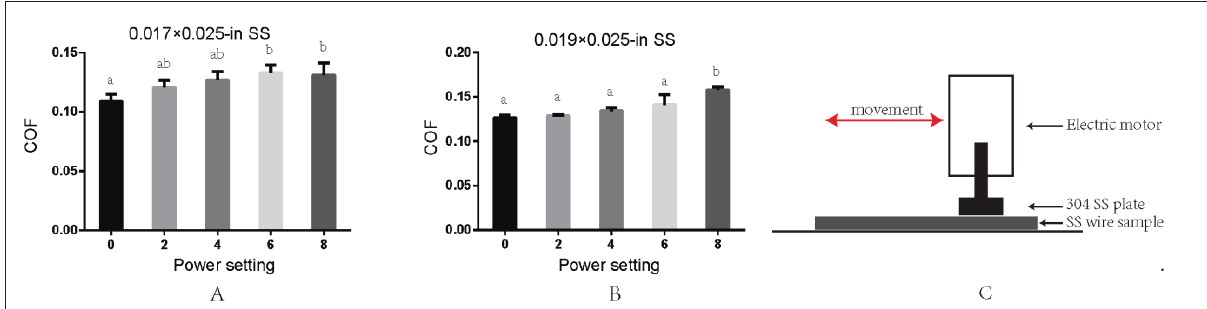
Figure 2. The COF of unheated and heated SS wire specimens. (A) Unheated 0.017 × 0.025 inch SS wire specimens and specimens heated at power settings of 2, 4, 6, and 8 for eight seconds. (B) Unheated 0.019 × 0.025 inch SS wire specimens and specimens heated at power settings of 2, 4, 6, and 8 for eight seconds. (C) Illustrative artwork of the experiment